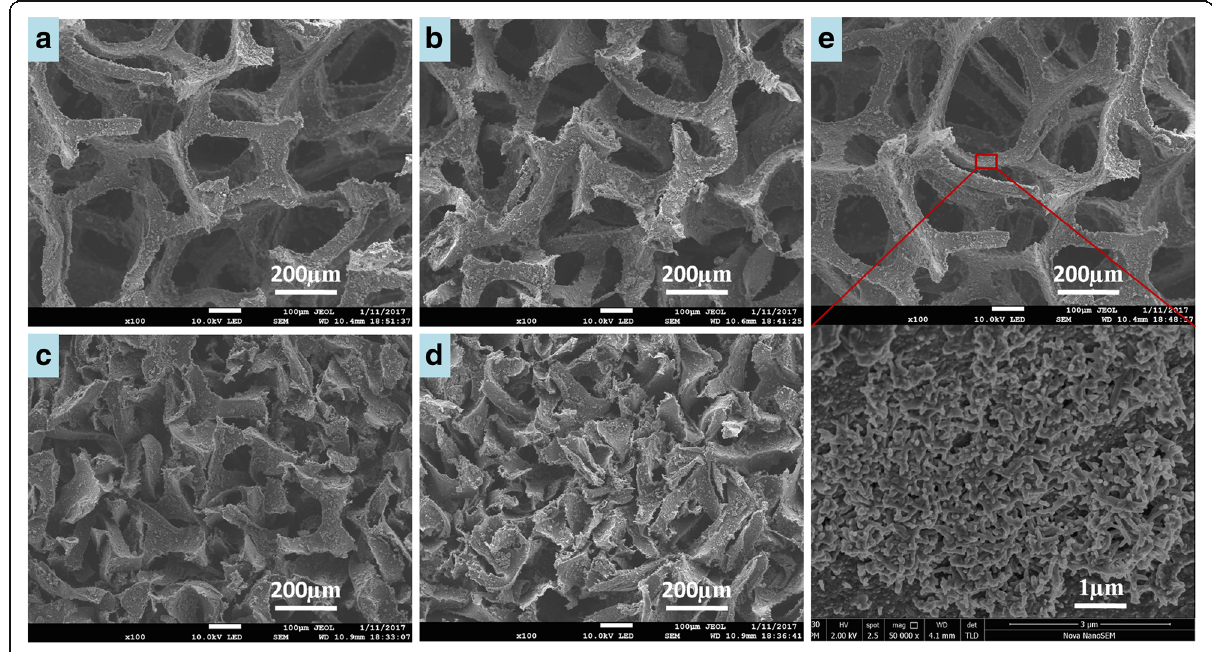
Fig. 8 SEM images of microporous structure of PANI/sponge composite under different pressures with approximate compression ratio of a 0%, b 20%, c 40%, and d 60%. e SEM images of the composite after multiple pressures under different